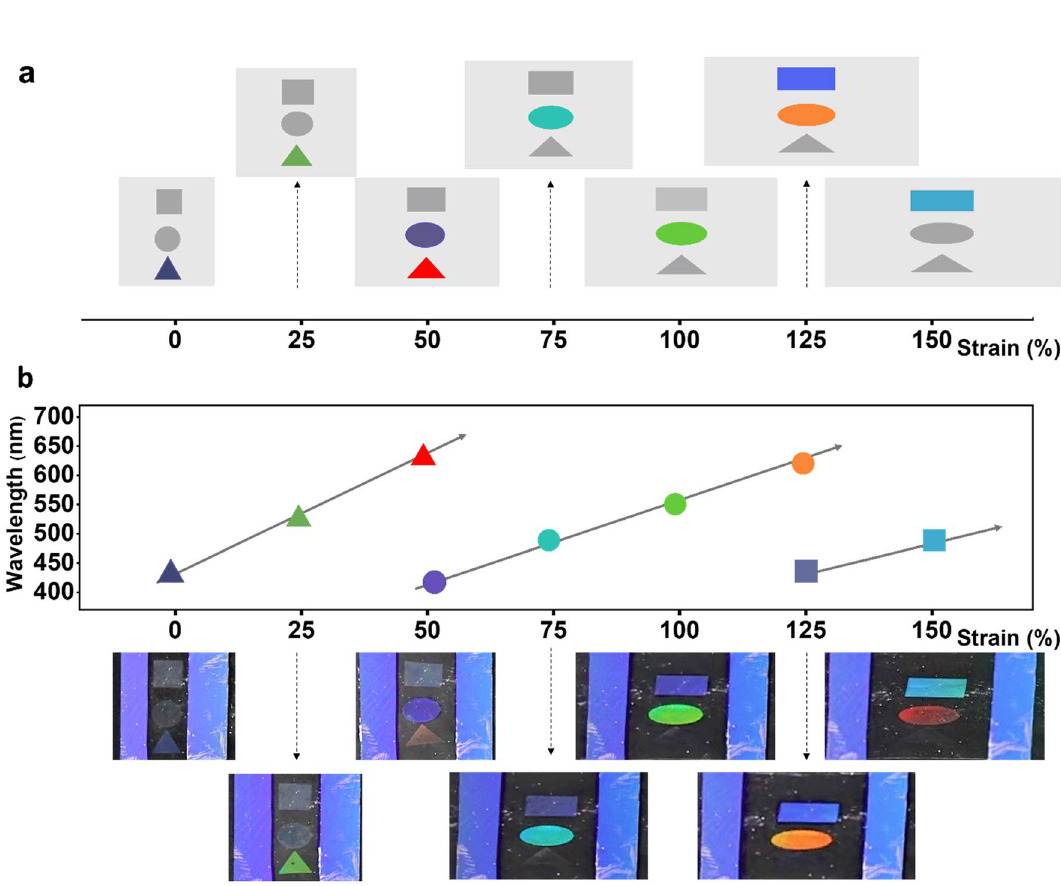
Figure 9. ( a ) Working principle to expand strain range up to 150% by integration of three different periodic nanostructures. 780, 510, and 356 nm periodic nanostructures were made in triangular, circular and square areas respectively. ( b ) Photos and diffracted wavelengths of triangular (0–50% strain), circular (50–125% strain), and square (125–150%)